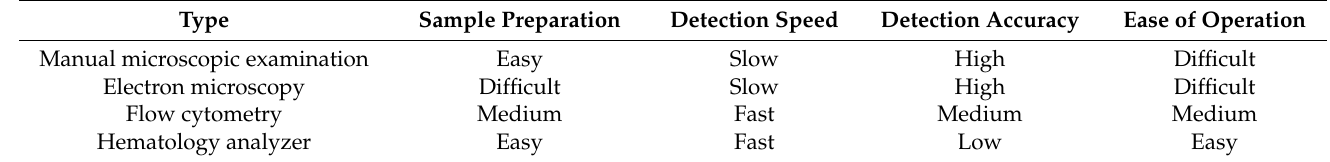
Table 1. Comparison of different blood cell analysis